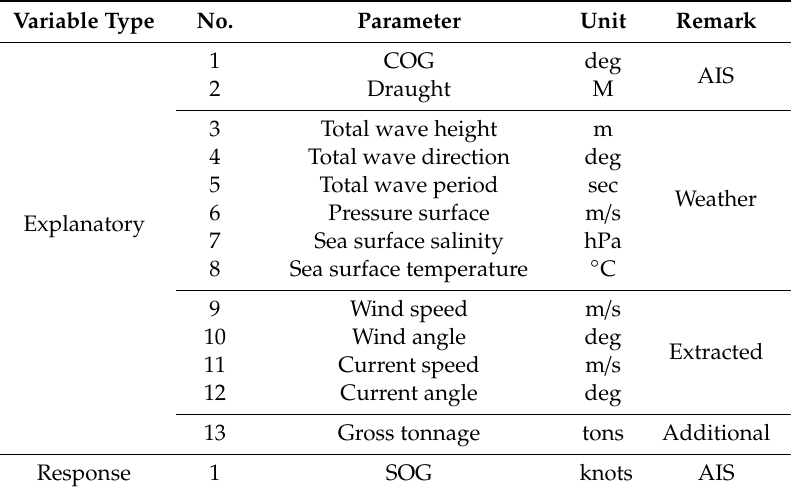
Table 8. List of selected explanatory variables.